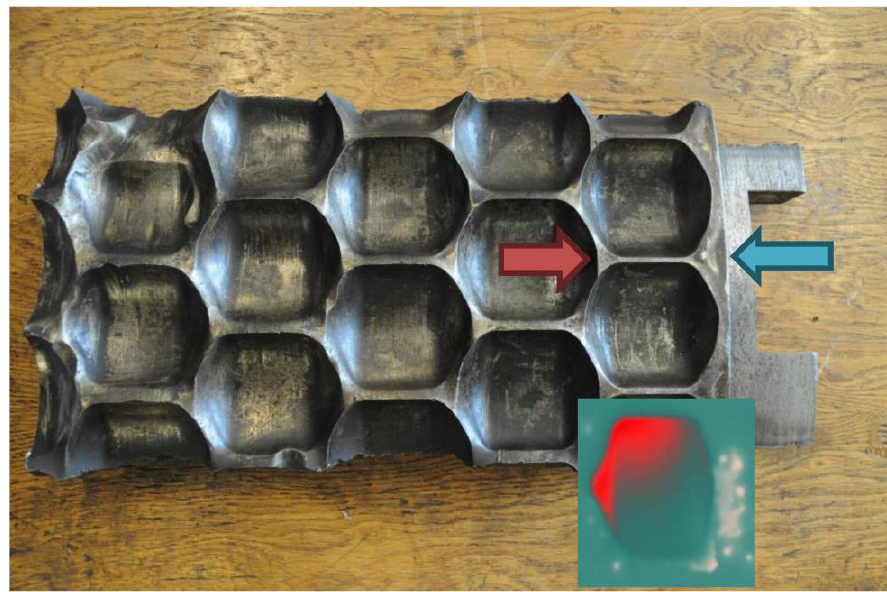
Figure 14. Fragment of a worn-out industrial molding ring compared to thermogram of the briquette.